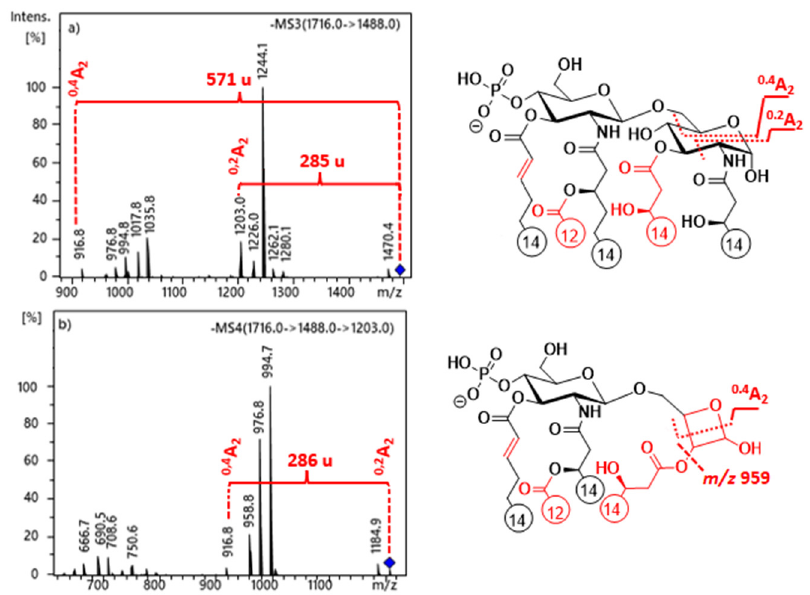
Figure 3. ESI-ion trap mass spectra obtained at MS 3 and MS 4 stages of selected ions at ( a ) m / z 1488 and ( b ) m / z 1203 for PHAD-504, demonstrating the structural relationship between 0,2 A 2 and 0,4 A 2 cross-ring fragment ions in 3-acyl lipid A.